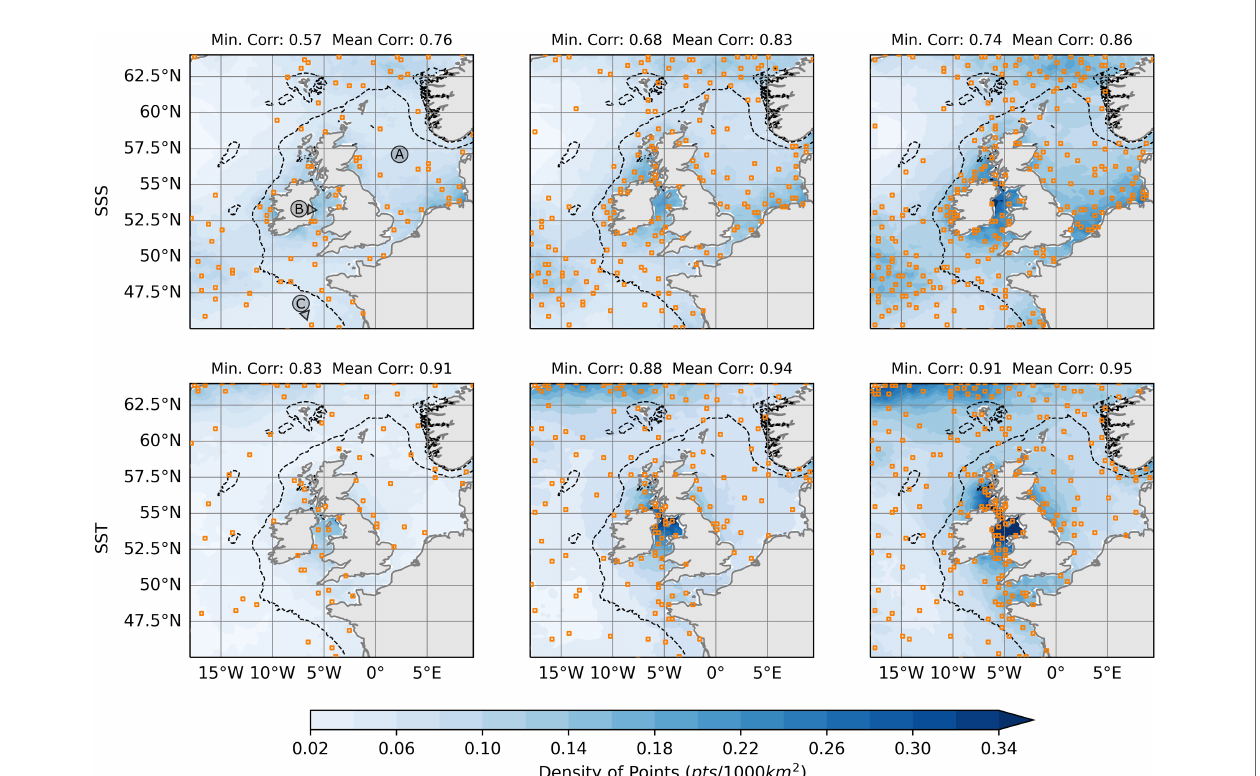
FIGURE 2 | Suggested observation locations (orange squares) due to the Modi fi ed Greedy Set Cover algorithm for different numbers of points. Results are shown for Temperature (deseasonalized) and Salinity at 0m. The left, middle and right columns show results for 100, 200 and 300 points respectively. Blue shading shows estimates of the density of observation locations throughout the domain. Black dashed lines show the 200m bathymetric contour. In the top left panel, three geographical locations are indicated: (A) North Sea, (B) Irish Sea and (C) Bay of